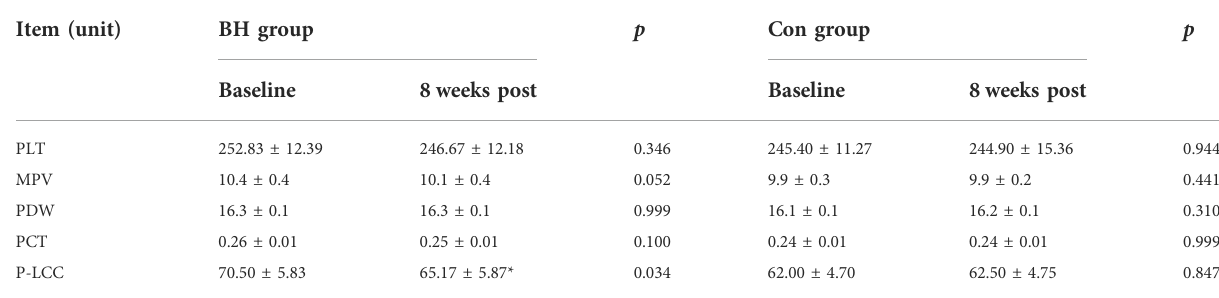
TABLE 3 Variation of platelet-related indicators.